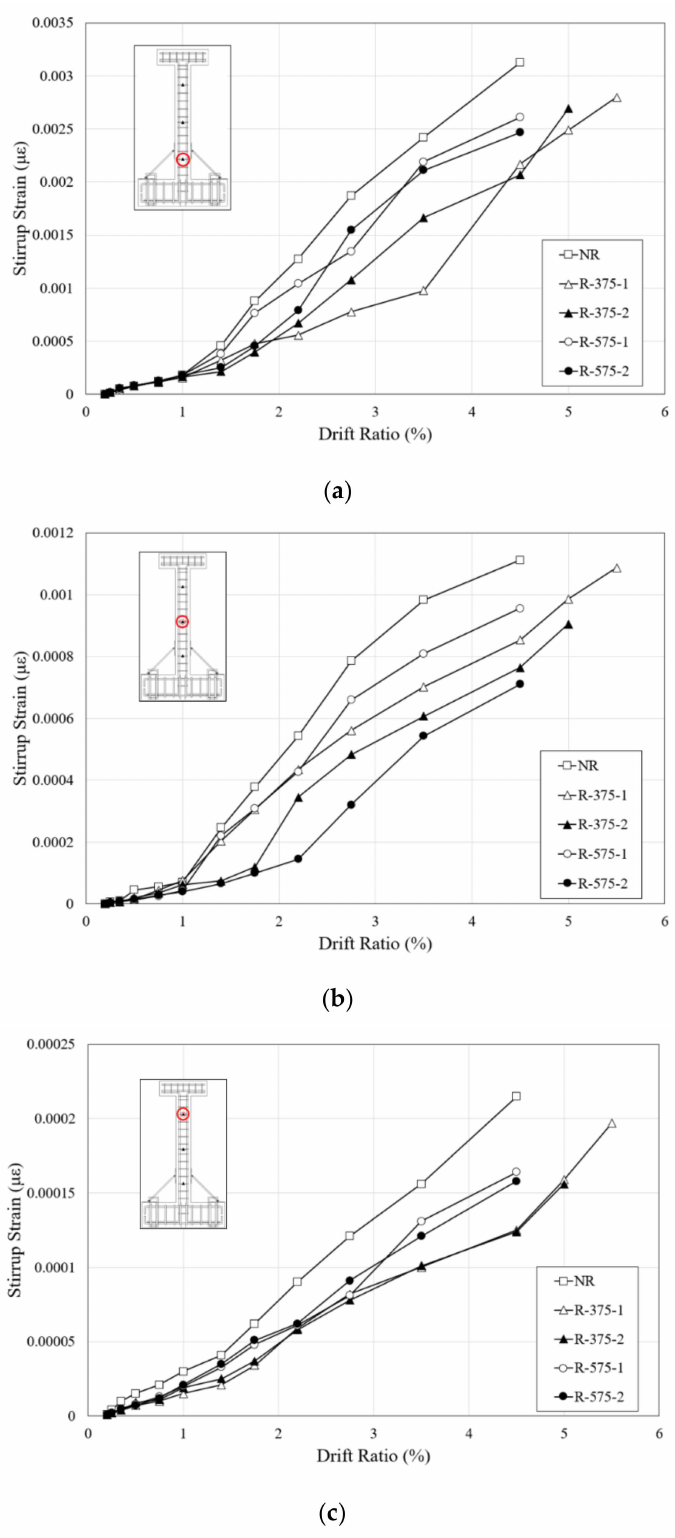
Figure 13. Stirrup strain-drift ratio curves: ( a ) Bottom; ( b ) Middle; ( c )